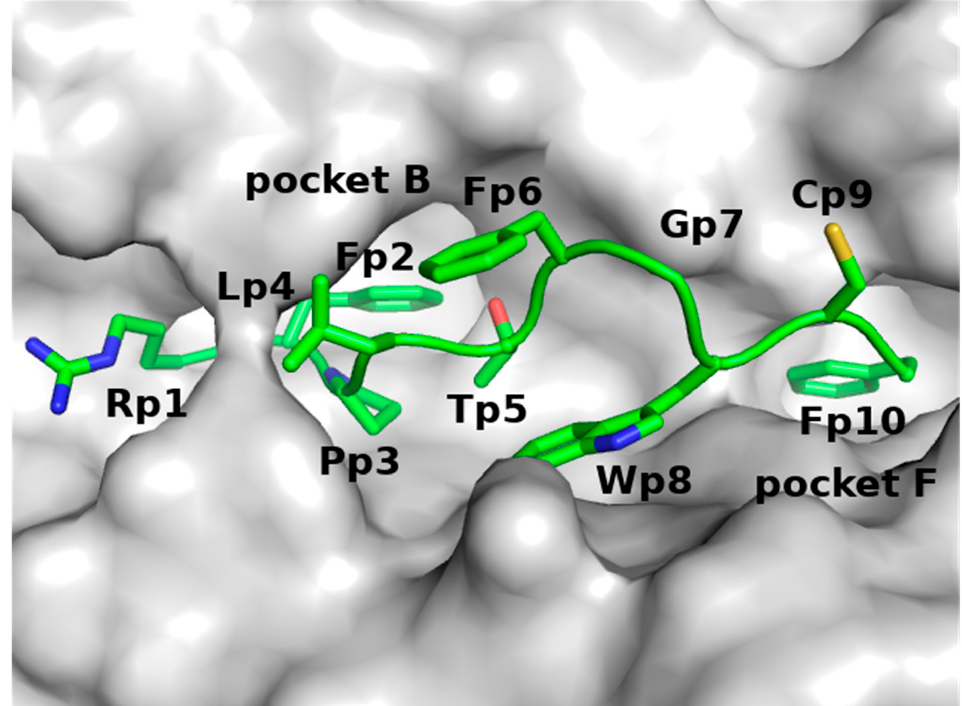
Figure 1. The pocket of A24 in complex with the HIV peptide, taken from the crystal structure of the A24-HIV-TCR complex (PDB ID: 3VXU, resolution 2.7 Å), where A24 is in grey surface and the HIV peptide is in green sticks with Oxygen atoms in red and Nitrogen atoms in blue.